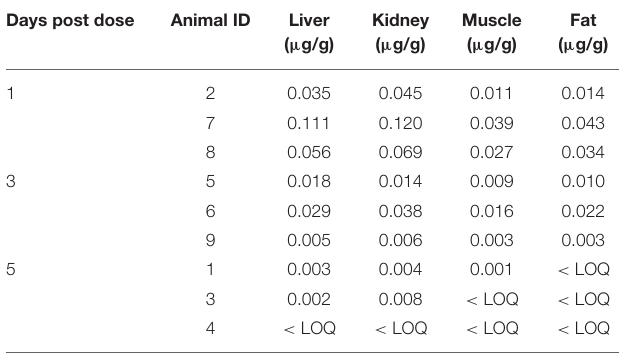
TABLE 3 | Comparisons of pharmacokinetic parameters of pantoprazole in domestic animal species, after single dose intravenous administration. Parameter